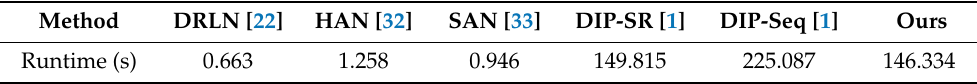
Table 2. Comparison of the averaged runtime when the size of the input LR image is 256 × 256 × 3.